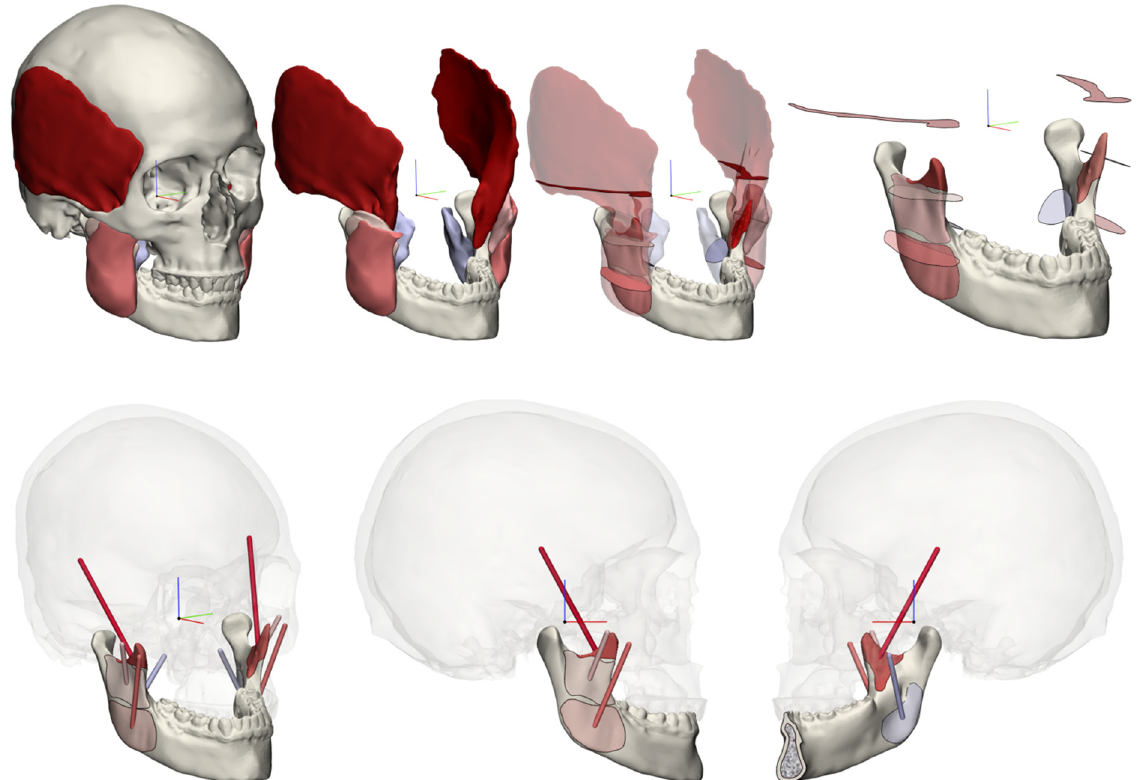
Figure 1. Visualisation of the smooth delineated muscles obtained from MRI data. The m. masseter superficialis, m. masseter profunda, m. pterygoideus medialis, and m. temporalis were taken into account. The muscles were sliced to determine the maximum CSA ( upper ), and the force vectors were calculated between the origin and matching insertion areas for each muscle ( lower ).